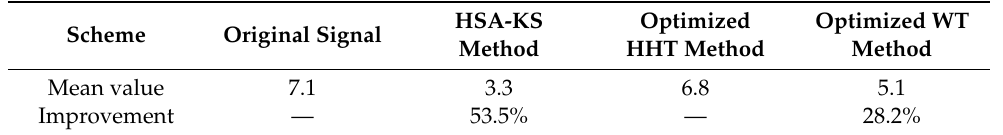
Figure 9. Boxplot of the D -values processed by the three schemes. Table 2. Mean value of the D- values (″) and the corresponding improvement of the GAT signals processed by the three schemes.